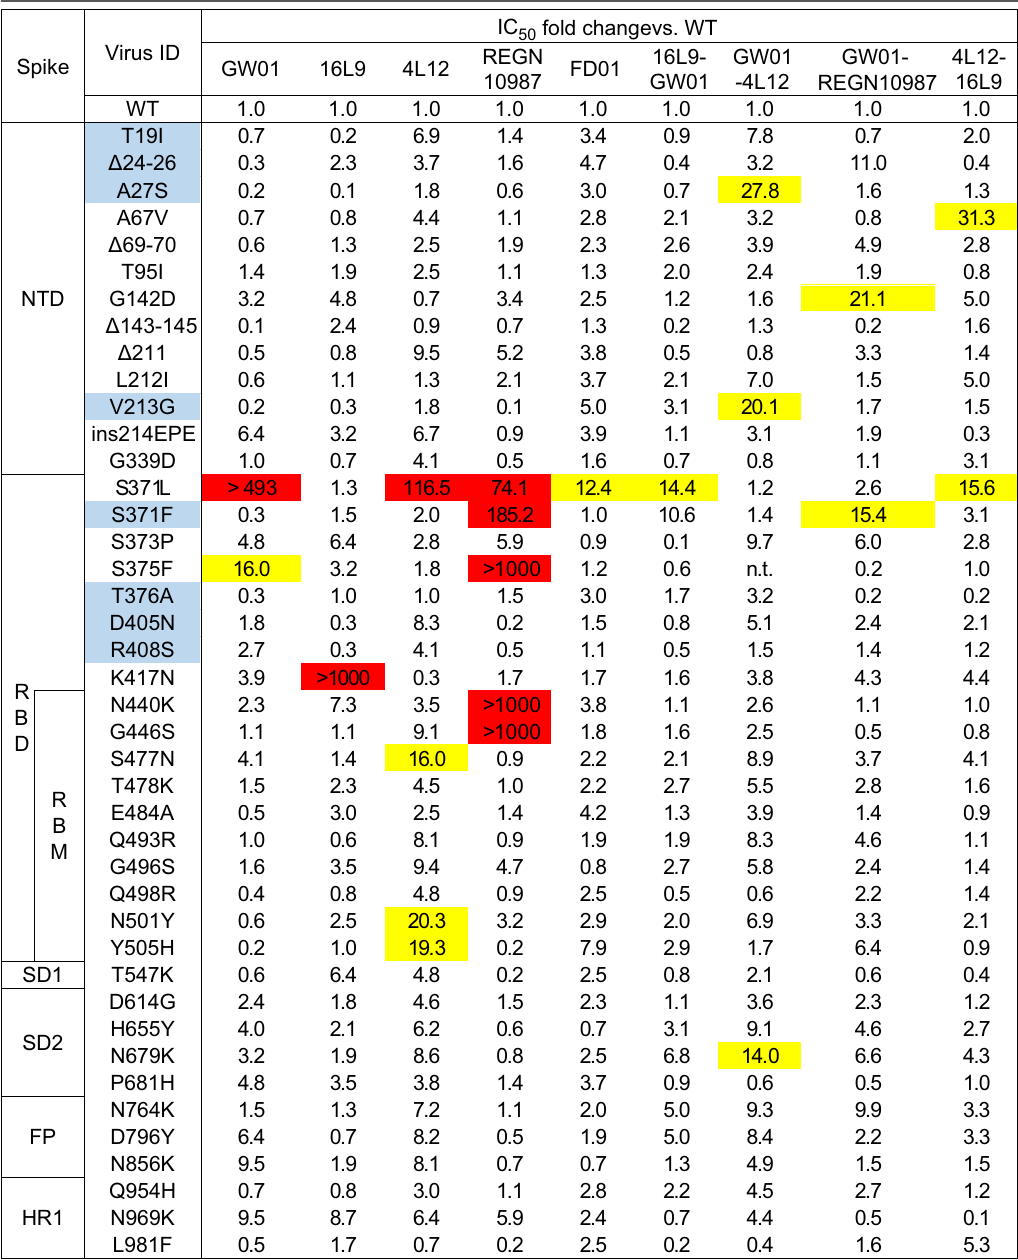
IC 50 fold changevs.